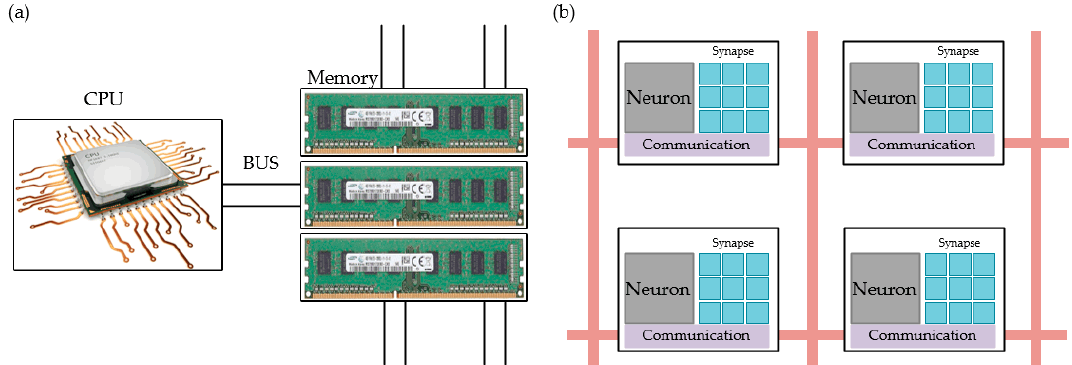
Figure 10. ( a ) Computing systems based on traditional Von Neumann architecture, the memory address of program instruction and the memory address of data point to di ff erent physical locations in the same memory device. ( b ) Computing systems based on neuromorphic architecture with integration of a single synaptic device into each